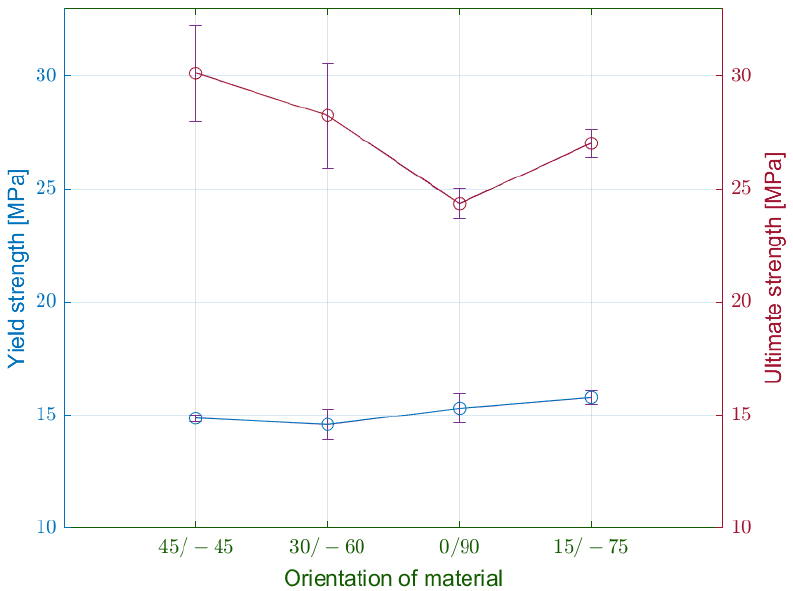
Figure 10 . Comparison of measured average values of yield strength and ultimate strength for selected infill orientations.